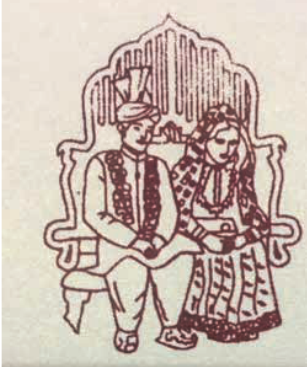
Figure 9: Images used in invitations